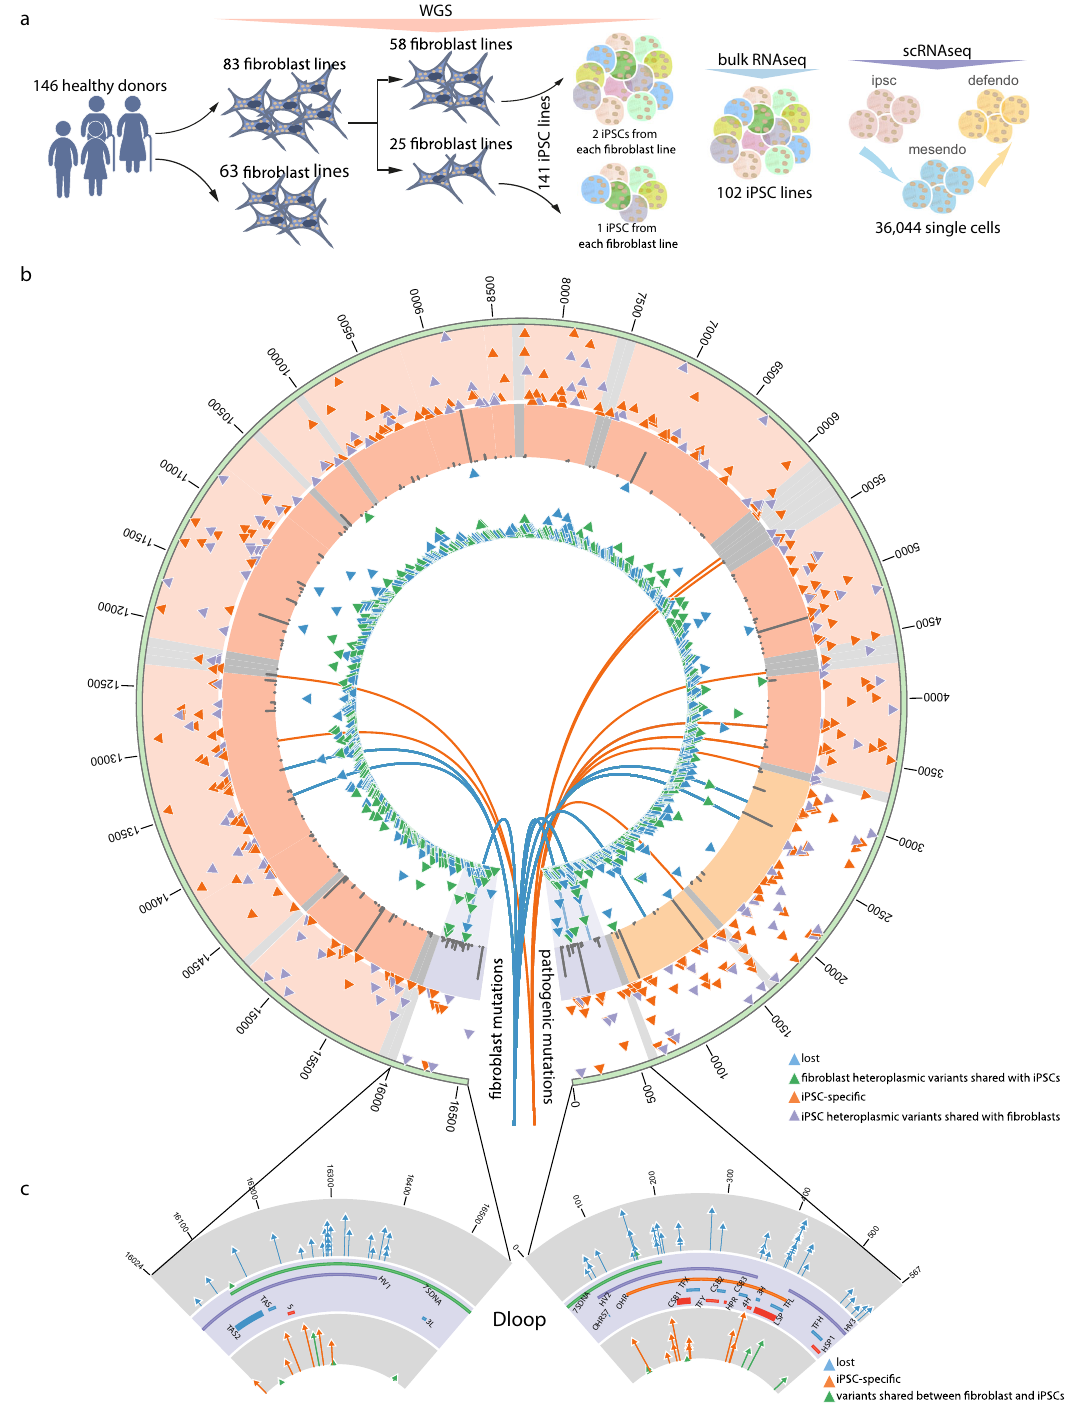
Fig. 1 mtDNA heteroplasmic variants detected from whole-genome sequences. a Summary of bulk whole-genome (WGS), bulk RNA and single-cell RNA (scRNA) sequencing data analysed in this study. Colour represents the heterogeneity of cell populations under WGS and bulk RNA-seq, and three different cell stages under scRNAseq, where mesendo = mesoderm, and defendo = de fi nitive endoderm. b Heteroplasmic variants detected from WGS. Circos plot from outside the circle to inside: (1) mtDNA position; (2) heteroplasmic variants identi fi ed in 141 iPSC lines; (3) minor allele frequency of common variants (MAF > 1%) in European population 55 ; mtDNA genes (purple — D-loop, red — coding region, yellow — rRNAs and grey — tRNAs); (4) heteroplasmic variants identi fi ed in fi broblast cell lines; (5) blue lines pointing to the positions of variants speci fi c in fi broblast cell lines; (6) orange lines pointing to the positions of pathogenic mutations; (2) & (4) vertical axes represent the HFs; (3) vertical axes represent the frequencies of single-nucleotide substitutions. c High resolution of mtDNA D-loop region. Plots from top to bottom: (1) mtDNA position; (2) decrease shift variants; (3) D-loop regions; (4) increase shift variants; (2) & (4) vertical axes represent heteroplasmic